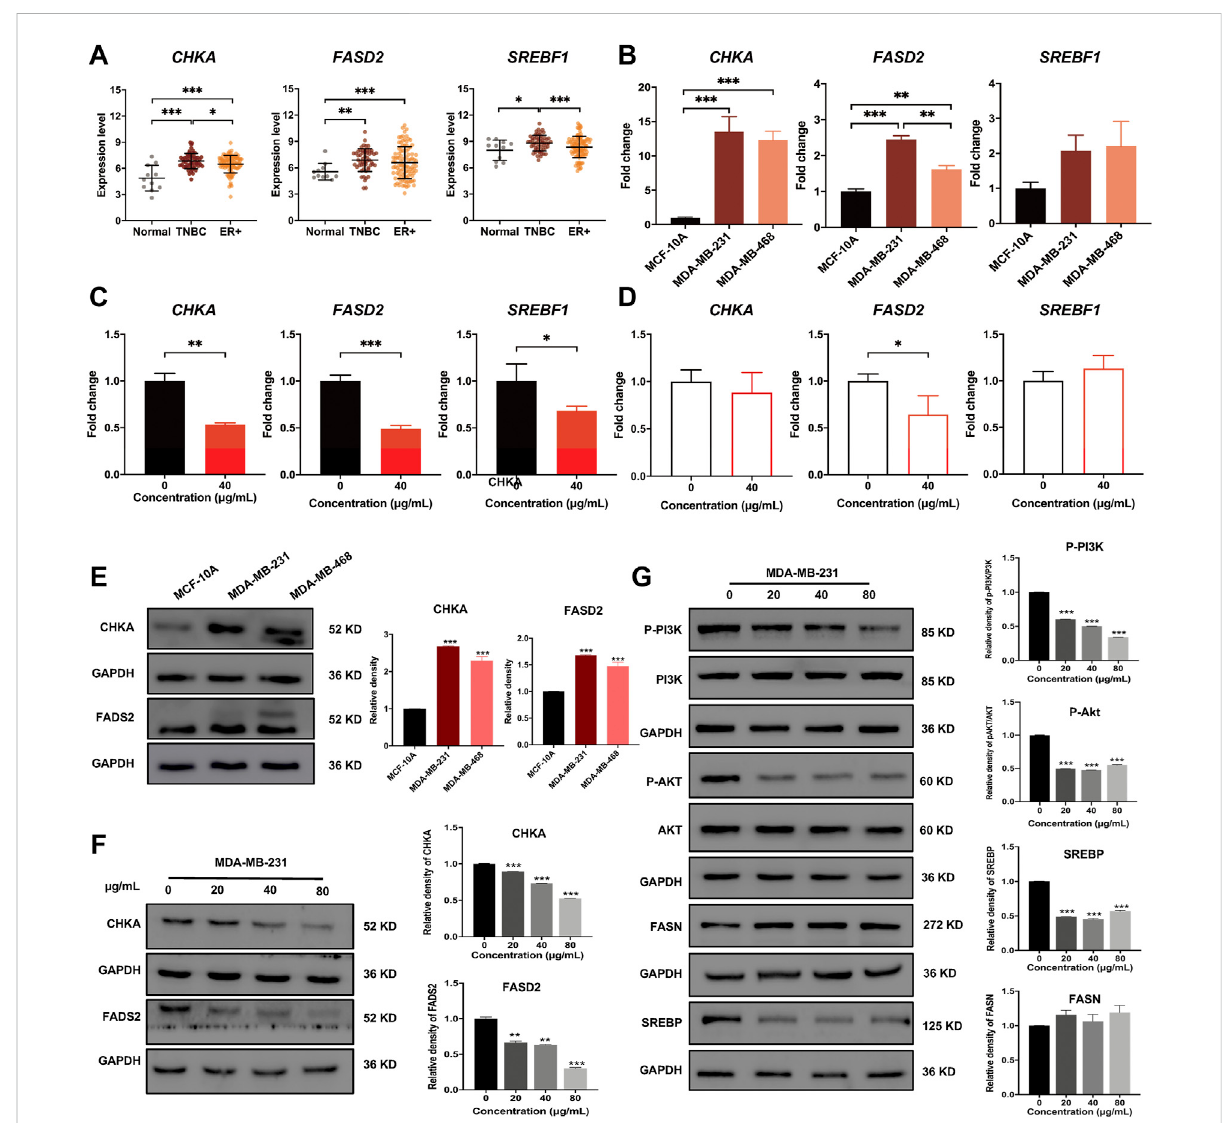
FIGURE 7 Dandelion extract inhibited mRNA and protein expression levels of metabolic-associated proteins and pathways. (A) The mRNA expression levels of CHKA, FADS2 , and SREBF1 in normal, TNBC, and ER + breast cancer tissues based on the GSE65194 dataset. (B) The mRNA expression levels of CHKA, FADS2 , and SREBF1 in TNBC and normal cells by RT-PCR. (C) The mRNA expression levels of CHKA, FADS2 , and SREBF1 after dandelion extract treatment in MDA-MB-231 cells by RT-PCR. (D) The mRNA expression levels of CHKA, FADS2 , and SREBF1 after dandelion extract treatment inMCF-10AcellsbyRT-PCR. (E) TheproteinexpressionlevelsofCHKAand FADS2inMCF-10Aand TNBCcells. (F) Theproteinexpression levels of CHKA and FADS2 in MDA-MB-231 cells after dandelion extract treatment. (G) The expression levels of p-PI3K, p-AKT, SREBP, and FASN in MDA-MB-231 cells after dandelion extract treatment. *p < 0.05, **p < 0.01, ***p < 0.00